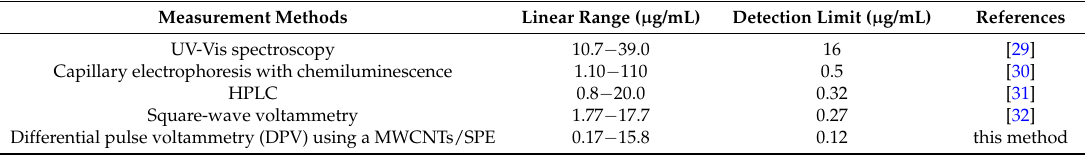
Table 1. Comparison of our research with other methods for CGA detection.